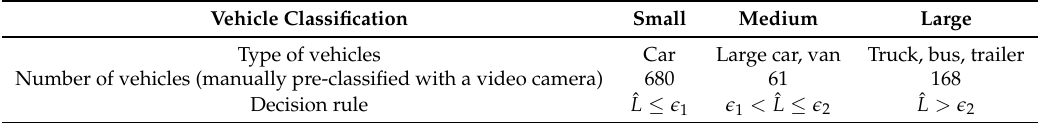
Table 1. Vehicle classifiation using a length-based criterion, i.e., based on the ˆ L estimator of Equation